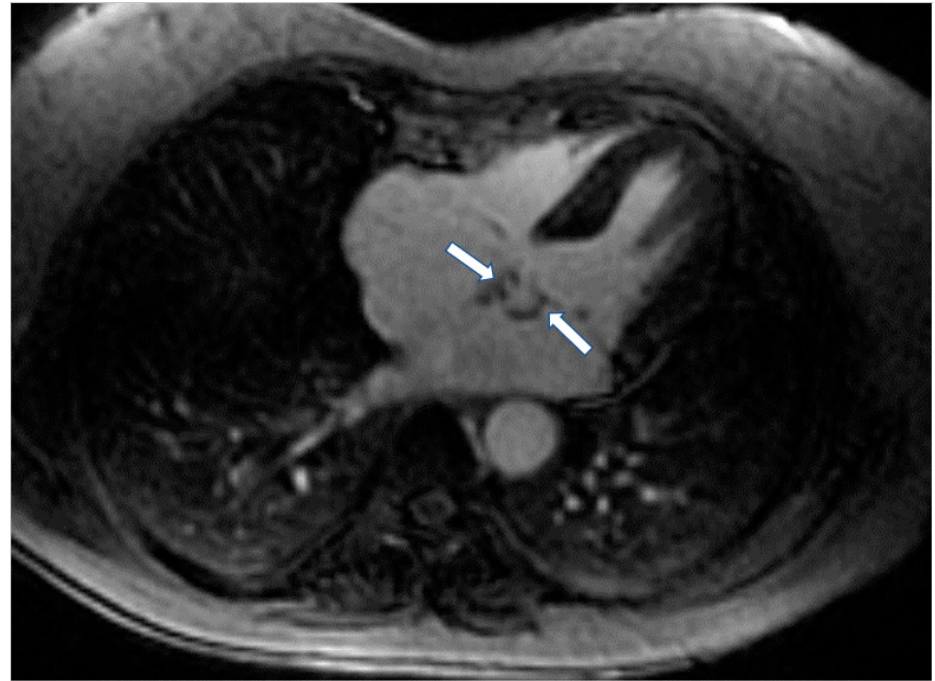
Figure 6. Four chamber inversion recovery image showing the presence of fibroma (arrows) in left atrium.